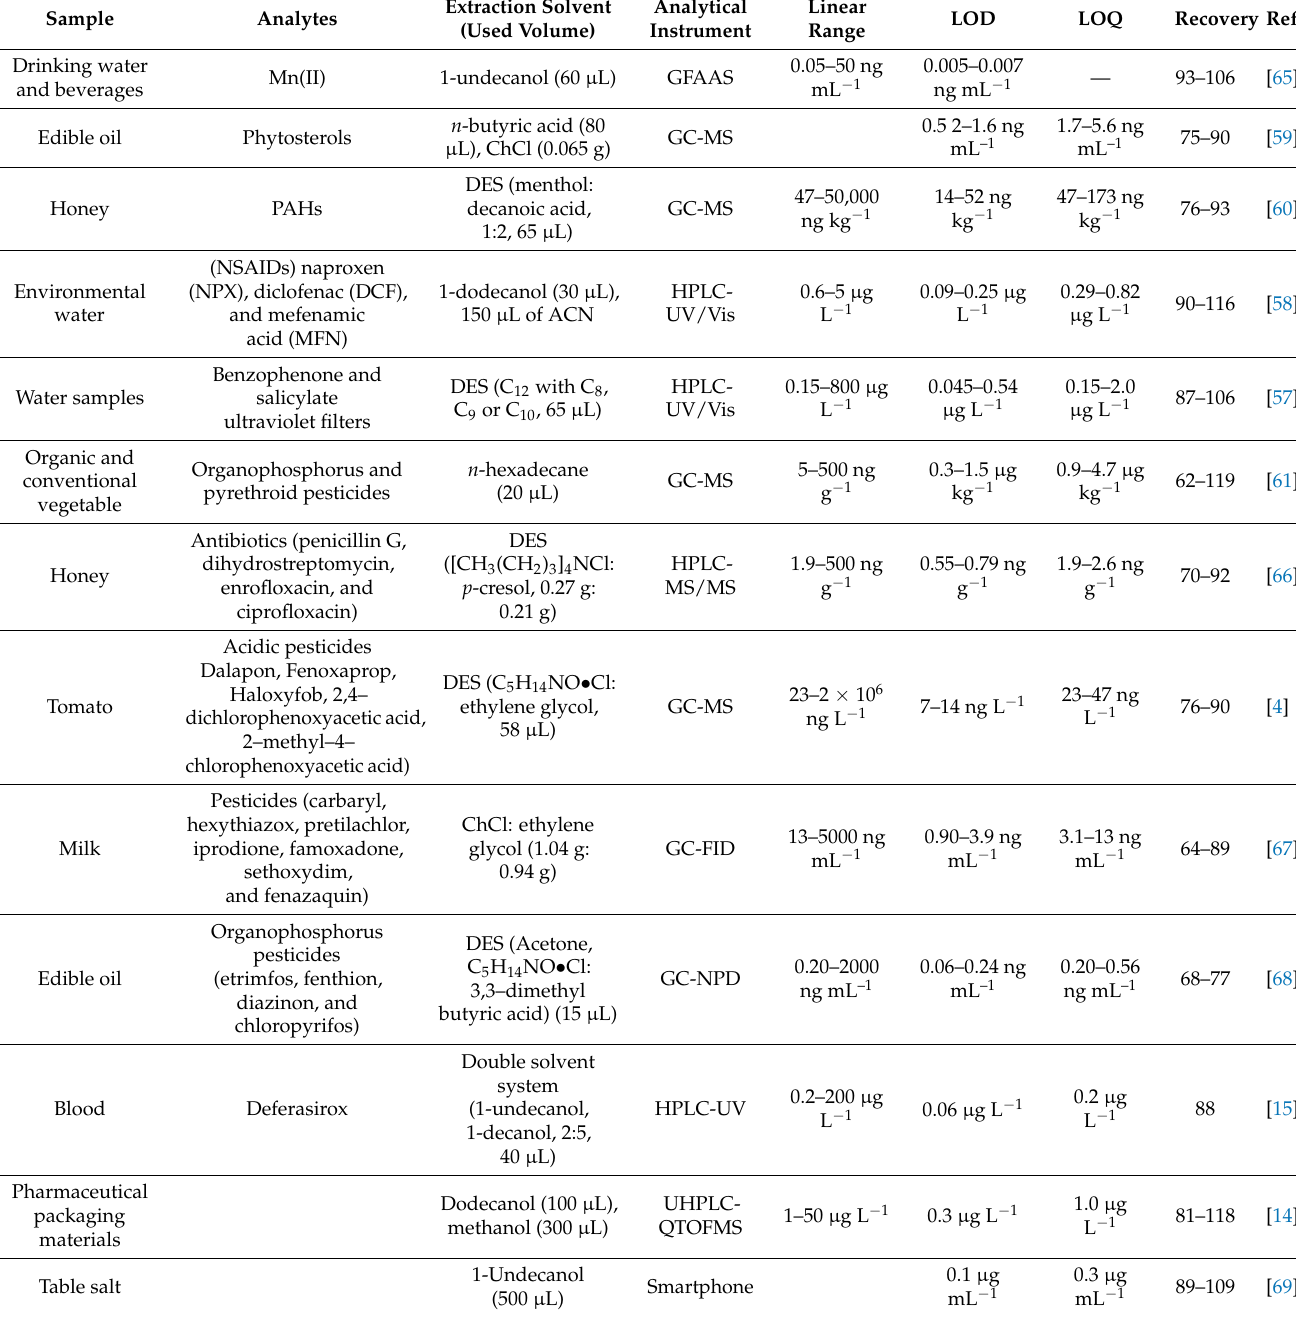
Table 3. Some applications of